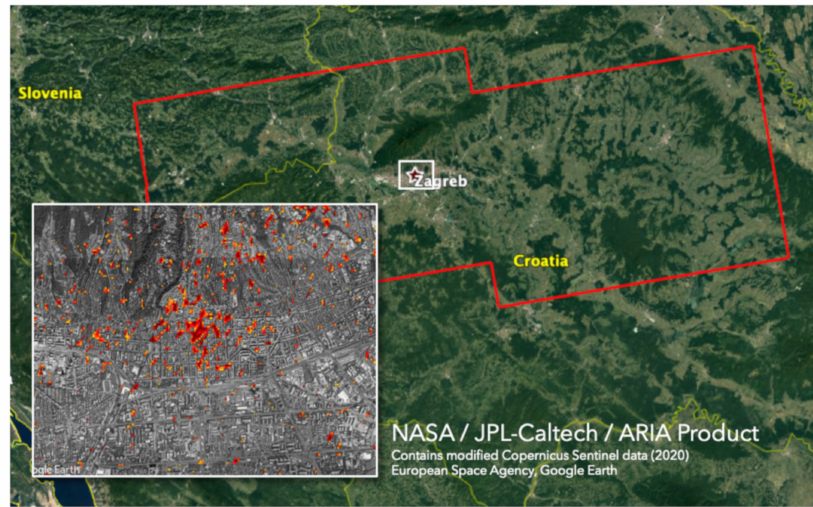
Figure 7. Damage proxy map created by the Advanced Rapid Imaging and Analysis (ARIA) team at NASA’s Jet Propulsion Laboratory (JPL) and the California Institute of Technology. This map contains modified Copernicus Sentinel data, processed by the ESA and analyzed by the NASA JPL / Caltech ARIA team. This task was carried out at the JPL, funded by NASA.